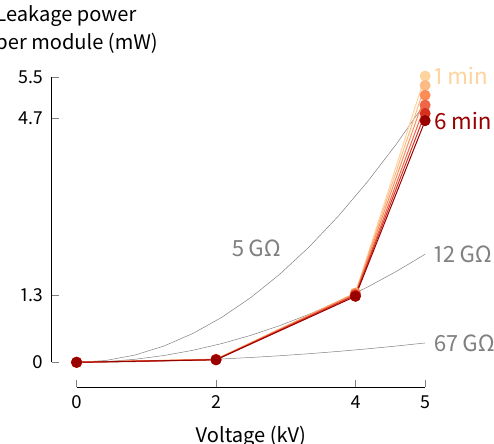
Figure 12. Current leakage through the dielectric causes our DET VSA to draw continuous electrical power while holding reduced stiffness as determined from measurements of the leakage current through five DET modules connected in parallel. The leakage power we measured was not consistent with the power dissipated through a constant resistance value (shown by the gray curves). The leakage power decreased over time while the DETs were held at constant